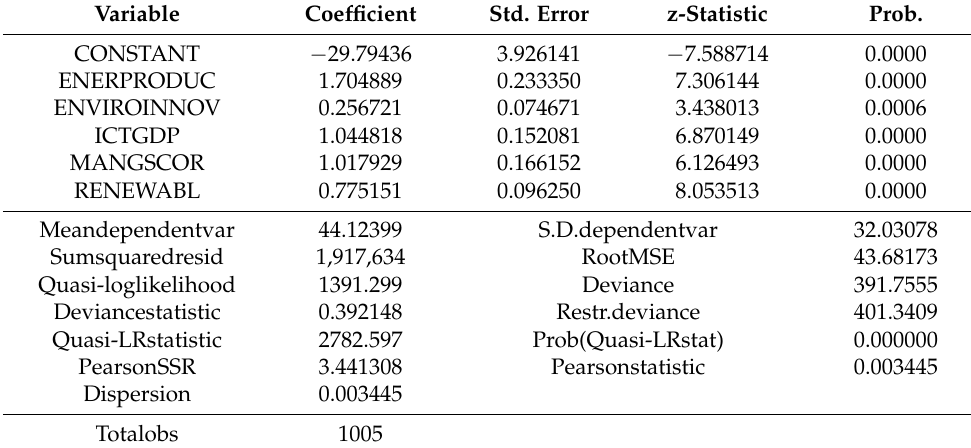
Table 5. Model estimation